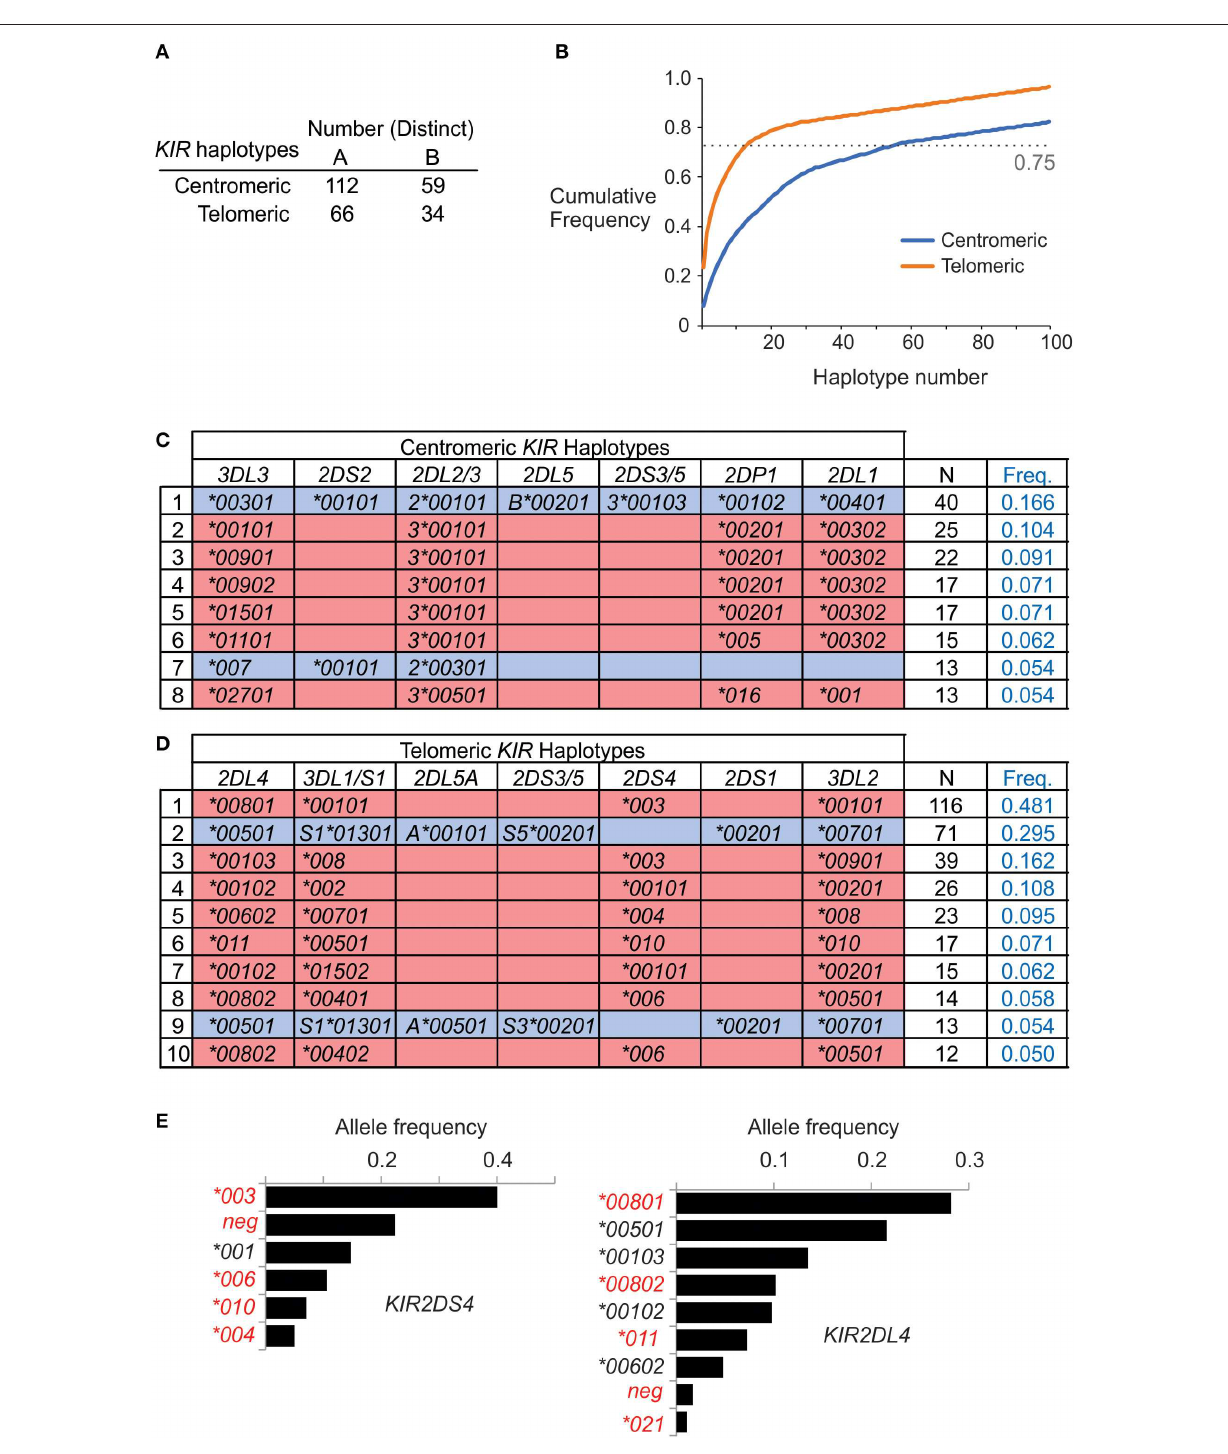
FIGURE 3 | Centromeric KIR are more diverse than telomeric KIR in Iranians. (A) Shows the number of distinct haplotypes observed in the centromeric and telomeric KIR regions. (B) Shows the cumulative frequency of haplotypes observed in the centromeric and telomeric KIR regions. (C,D) Shows the allele composition of all (C) centromeric, and (D) telomeric KIR haplotypes identified in more than ten individuals in the combined Iranian population. KIR A haplotypes are shaded pink and KIR B haplotypes are blue. Empty boxes indicate gene absence. At the right is shown number observed and the frequency in the combined Iranian population ( N = 241). All the observed haplotypes are given in Supplementary Material (E) . Shown are the frequencies of KIR2DL4 and KIR2DS4 alleles in the combined Iranian population. Red text indicates alleles not expressed at cell surface. The allele frequencies for all KIR genes in each of the five populations are given in Supplementary Material .